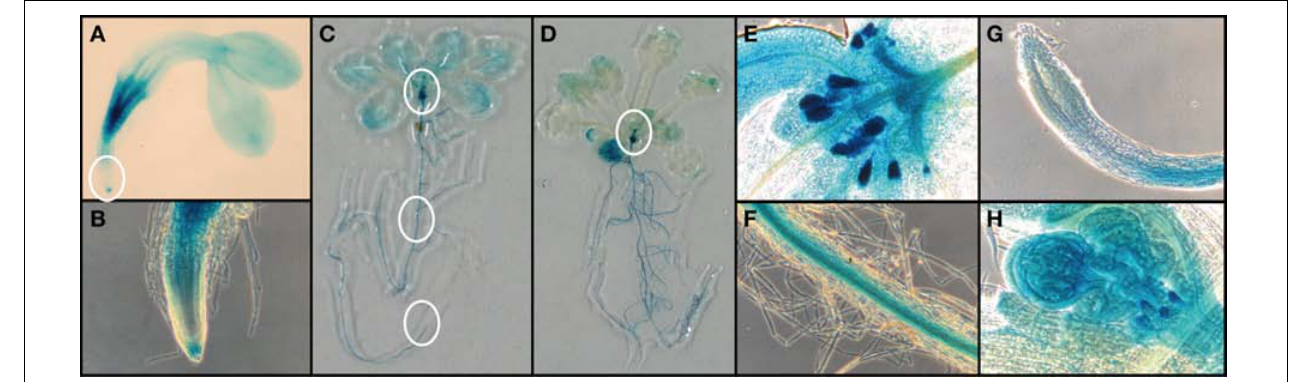
FIGURE 3 | Histochemical analysis of FC1pro::GUS line. (A) FC1 -dependent GUS activities in 2-day-old seedlings. (B) Zoomed image of regions of root cap and elongation zone as indicated by a white circle in (A) . Representative images of (C) 14-d-old seedling and (D) 21-day-old seedling. Zoomed image of regions of (E) primordial leaves, (F) root veins, and (G) veins as indicated by white circles in (C) . (H) Zoomed image of primordial bolting stem as indicated by a white circle in (D) .